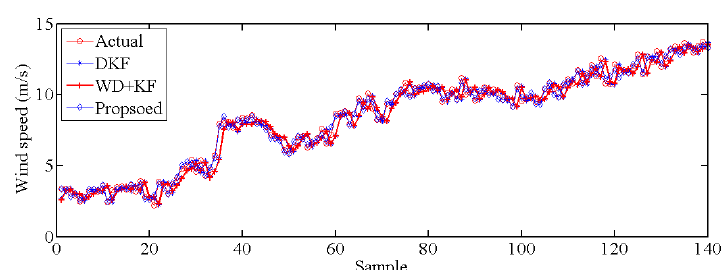
Figure 14. Prediction results from the different methods.